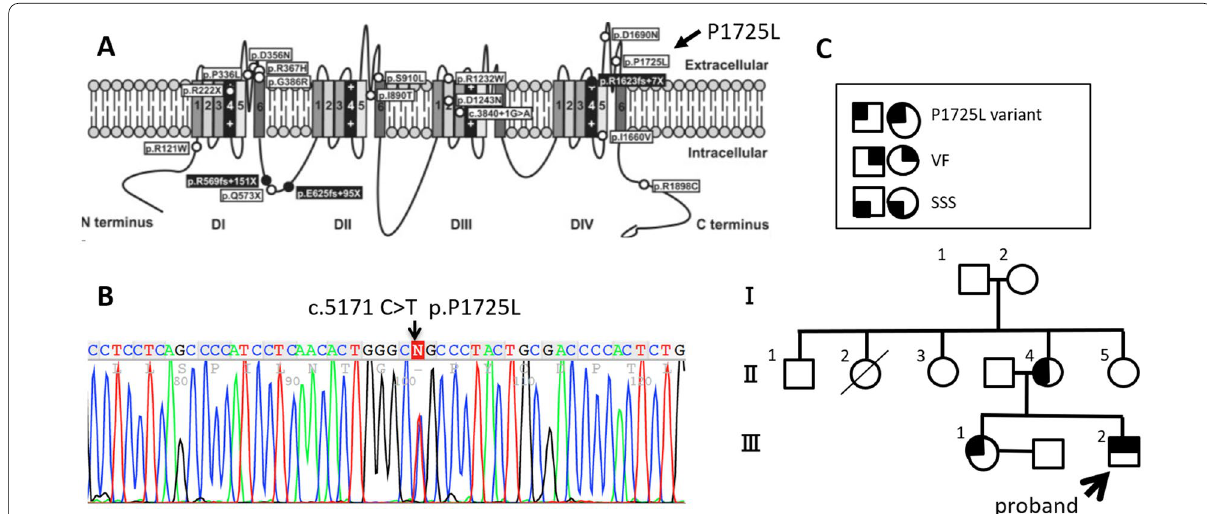
Fig. 2 Pedigree of the affected family and genetic testing of SCN5A gene revealing c.5174C>T, p.P1725L variant. a Topographic schema of sodium channel type 5 α-subunit. The mutation site p.P1725L is located in the pore region of domain 4 (figure was cited from Selga et al. [10]). b Sanger’s method shows three individuals had heterogeneous c.5174C>T (CCG > CTG), p.P1725L variant, which was previously reported in a patient with long QT syndrome. c The arrow indicates the proband, and the solid left upper quarter indicates members with P1725L variant, the solid right upper quarter indicates members with VF, and the solid left lower quarter indicates members with SSS. Oblique lines indicate dead